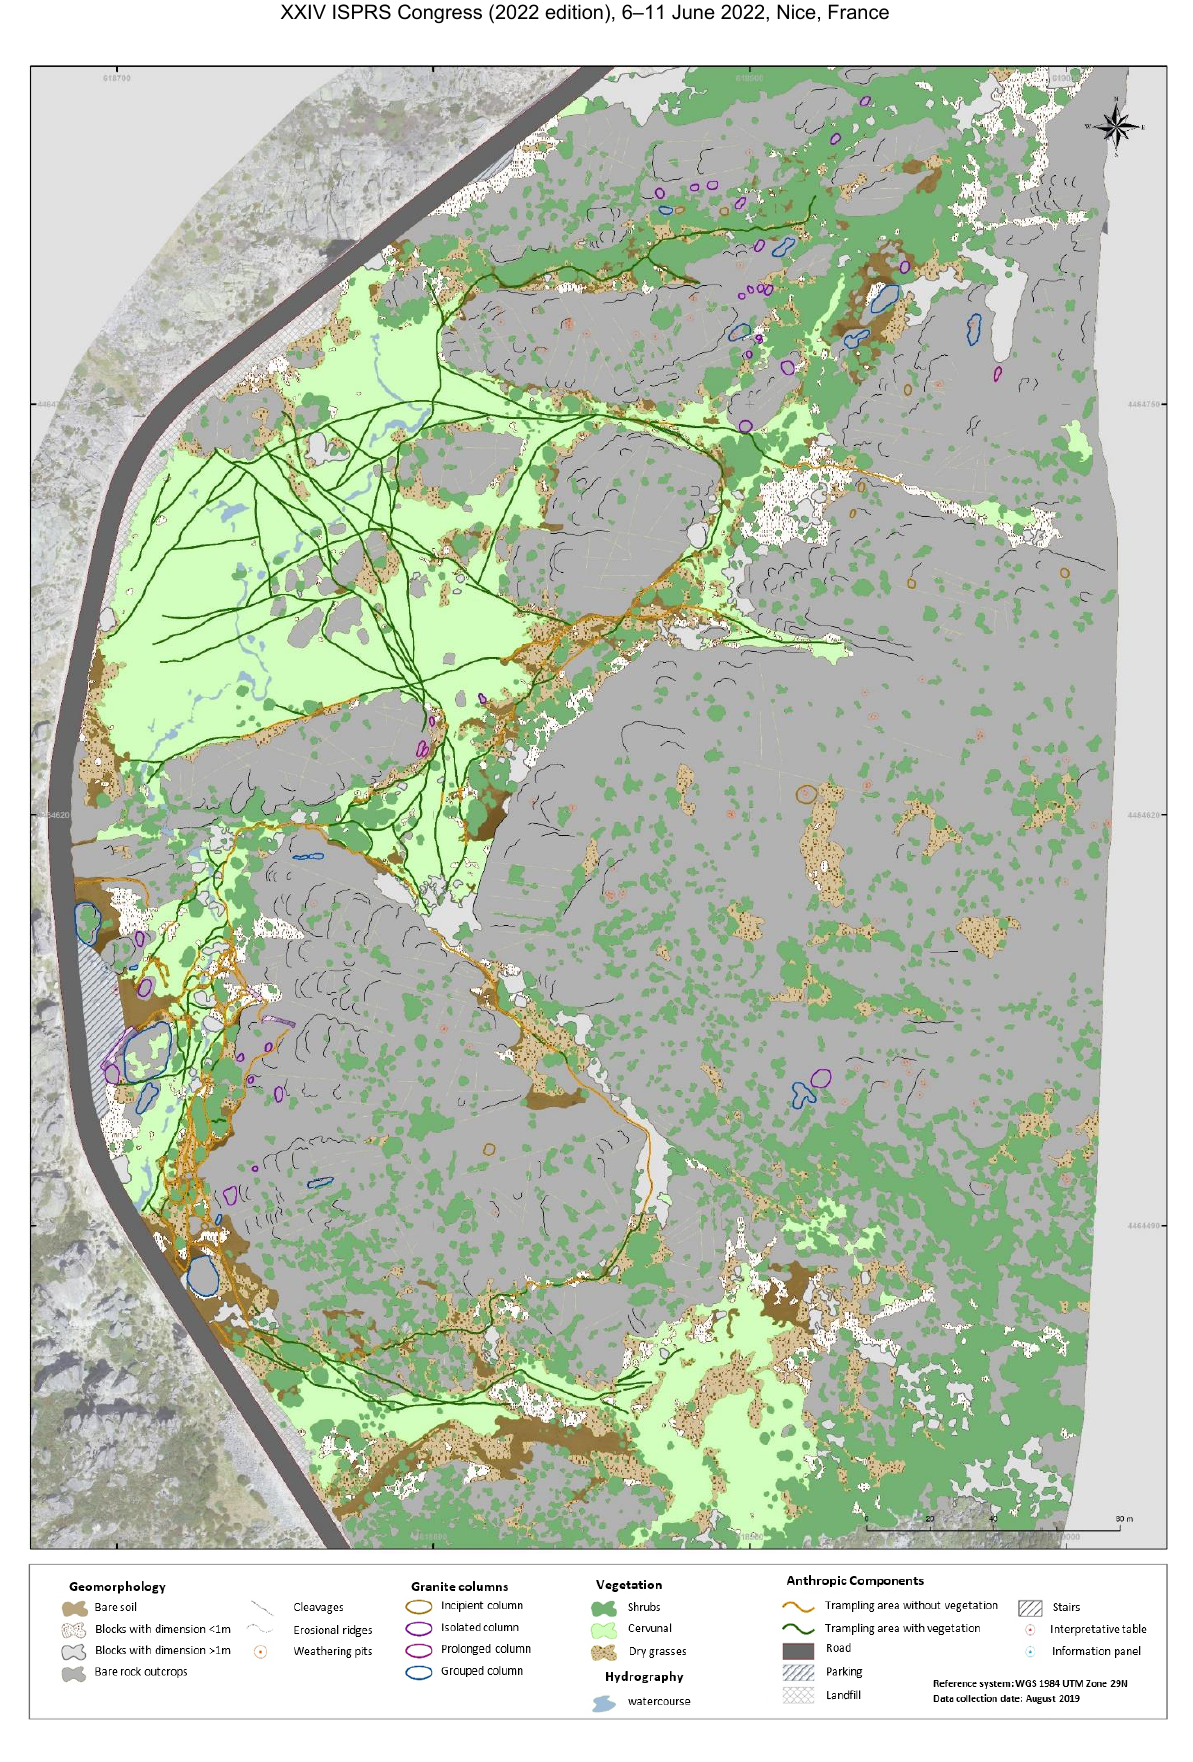
Figure 5. Ultra-high resolution map of the Covão do Boi